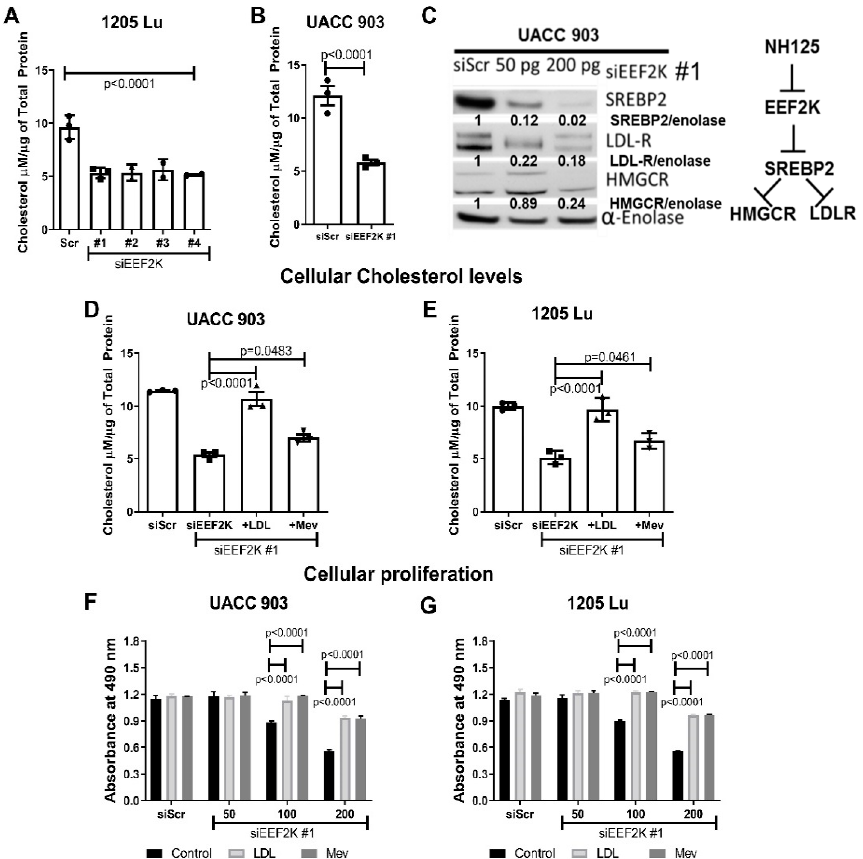
Figure 2. EEF2K modulated cholesterol metabolism in cancer cells. Genetic knockdown of EEF2K using siRNA (siEEF2K) reduced the cholesterol levels in 1205 Lu ( A ), UACC 903 ( B ) melanoma cell lines compared to scrambled siRNA knockdown. The cholesterol levels were normalized to the total protein content in cells. Significance was compared to scrambled siRNA knockdown (siScr) by t -test analysis ( n = 3). Knockdown of EEF2K led to a dose dependent reduction of major cholesterol biomarkers LDLR, HMGCR and SREBP2 as measured by protein levels. Alpha-enolase served as a protein loading control ( C ). The cholesterol levels were rescued by the addition of LDL or mevalonic acid (Mev) to the media of both UACC 903 ( D ) and 1205 Lu cells ( E ). Significance was compared to scrambled knockdown (siScr) by one-way ANOVA followed by Dunnett’s as post-hoc analysis. Similarly, addition of LDL and mevalonic acid to the cell growth media rescued the proliferation of both UACC 903 ( F ) and 1205 Lu ( G ) cells. Significance was compared to scrambled knockdown (siScr) by two-way ANOVA followed by Dunnett’s as post-hoc analysis ( n = 3).